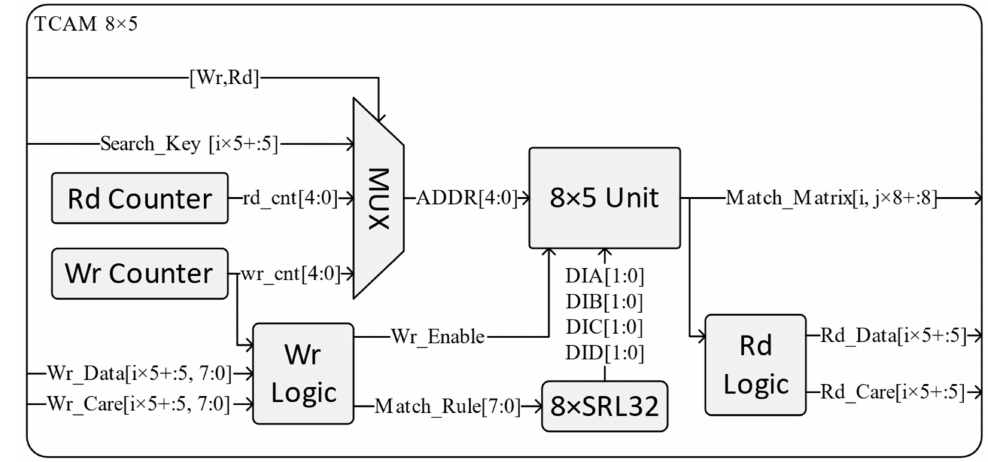
Figure 2. The proposed TCAM update